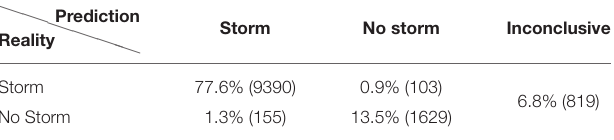
TABLE 8 | FNN 2 using L / I , Az , and V / I .